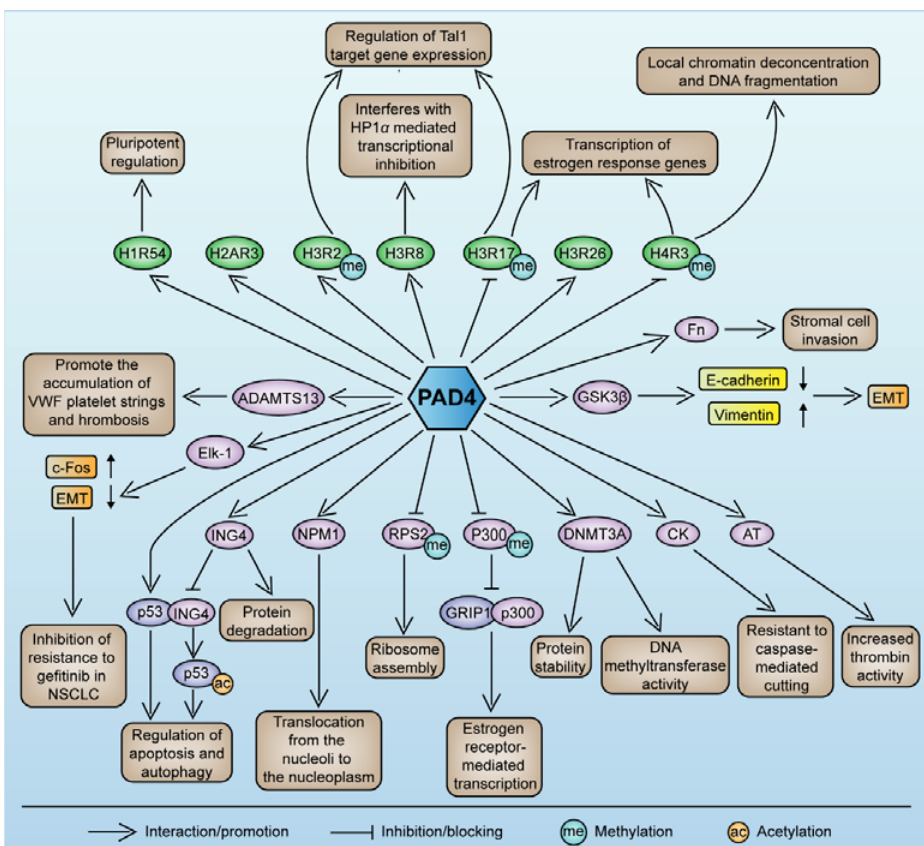
Figure 5. Schematic diagram showing the major substrates and regulatory mechanisms of PAD4 action. PAD4 citrullinates both histones (shown in green) and nonhistone proteins (shown in pink), regulating gene transcription alone or in combination with other PTMs. Me, methylation; Ac,